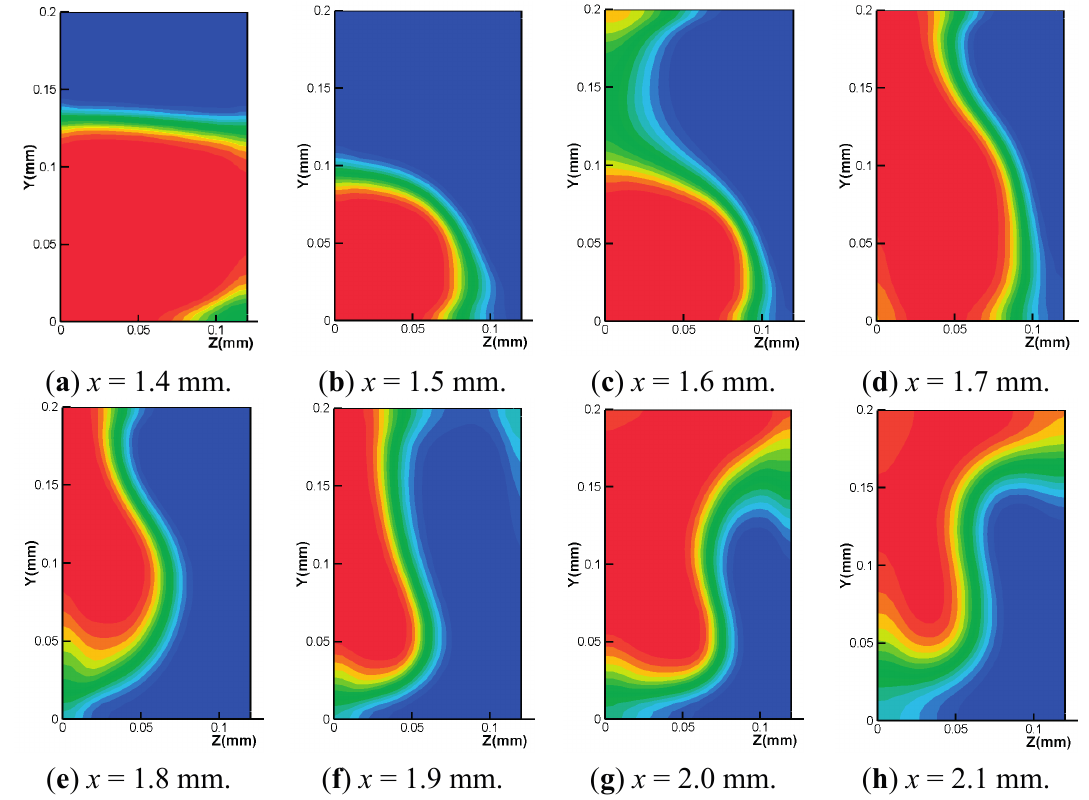
Figure 8. Development of the DOM distributions throughout the baffle